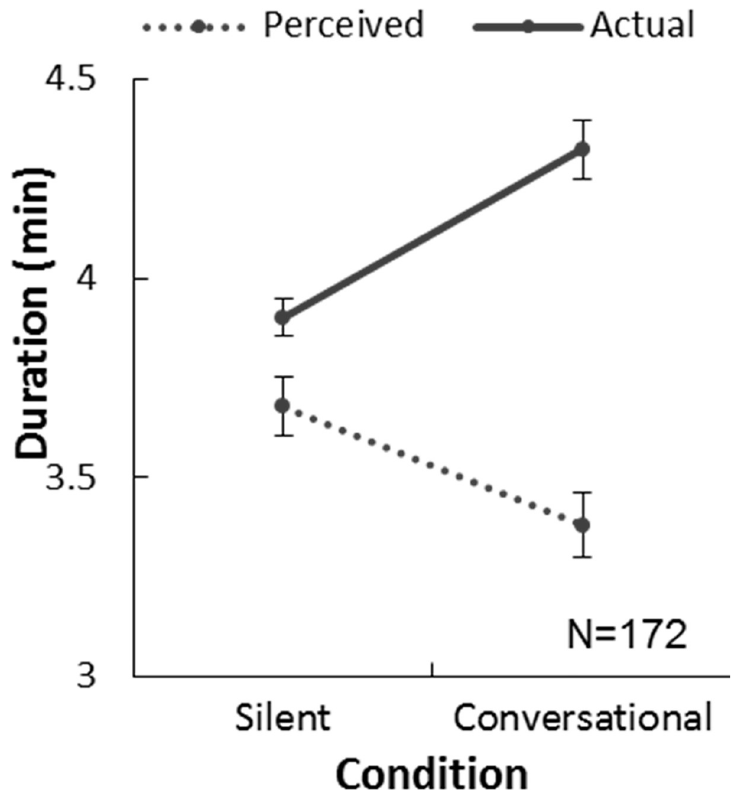
Fig 5. Perceived and actual duration of paired walk when silent and when conversing.